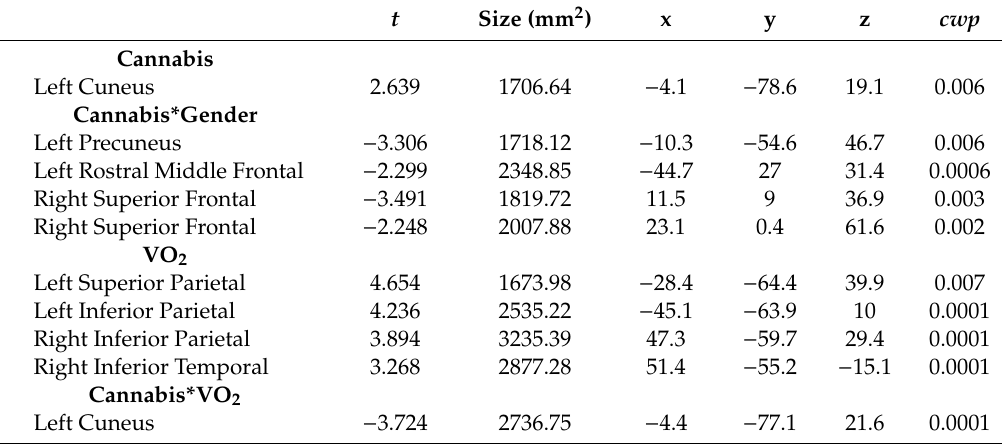
Table 2. Surface Area